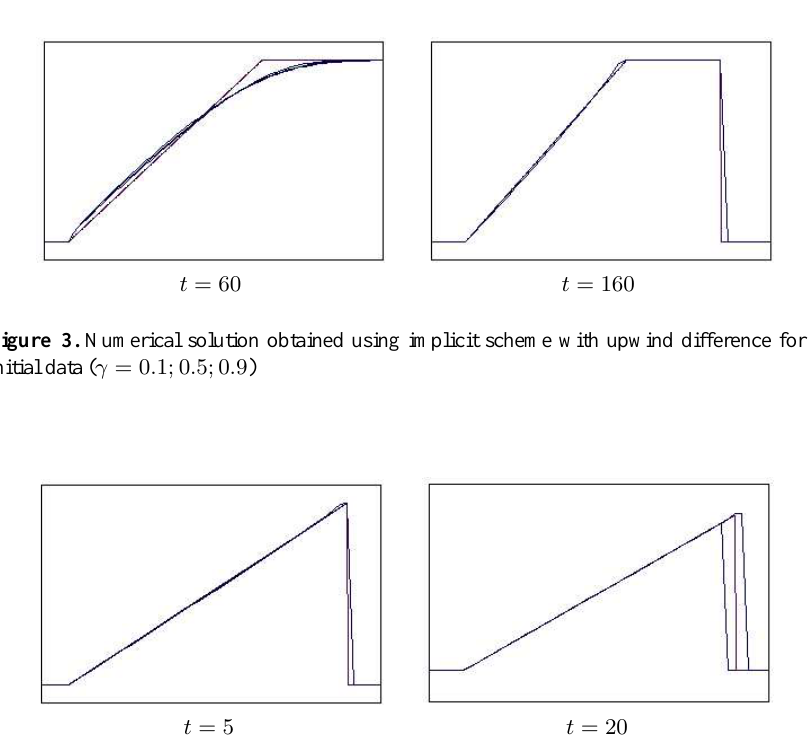
Figure 4. Numerical solution obtained using the implicit upwind scheme for 4 initial